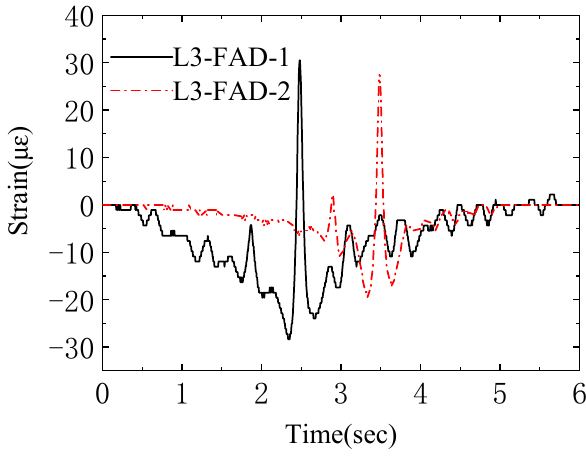
Figure 9. The strain signal of free-of-axel-detector (FAD) sensors in Lane 3.